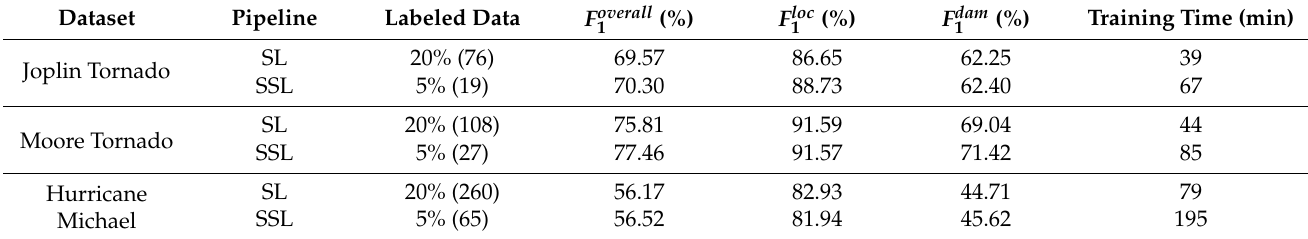
Table 7. Comparison of time cost between two training pipelines on three